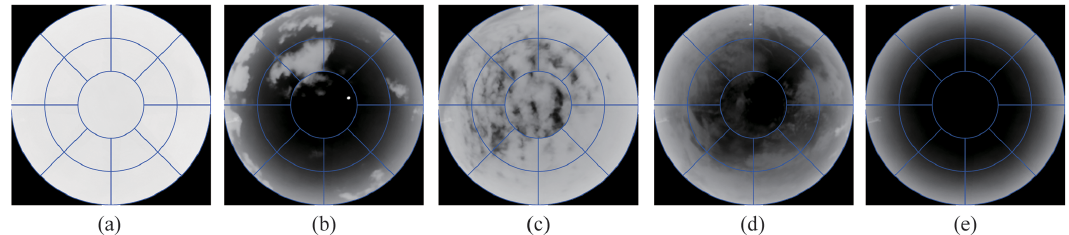
Figure 3. Cloud samples from the whole-sky dataset: (a) stratiform clouds, (b) cumuliform clouds, (c) waveform clouds, (d) cirriform clouds and (e) clear sky.